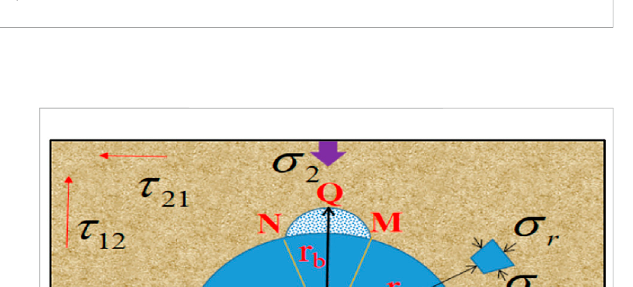
FIGURE 5 Schematic diagram for obtaining width and depth of borehole wall collapse area.